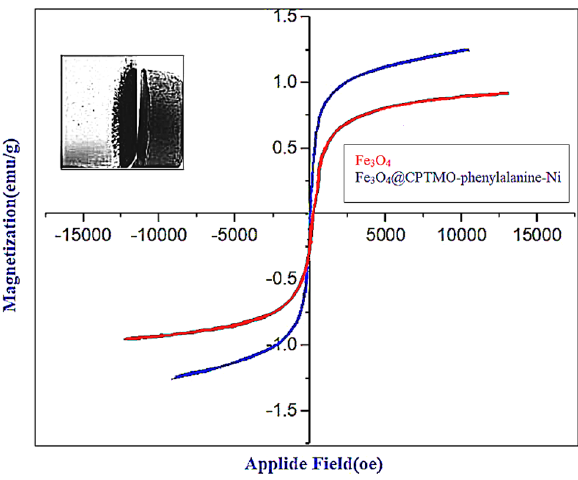
Figure 8. VSM data of Fe 3 O 4 @CPTMO-phenylalanine-Ni.